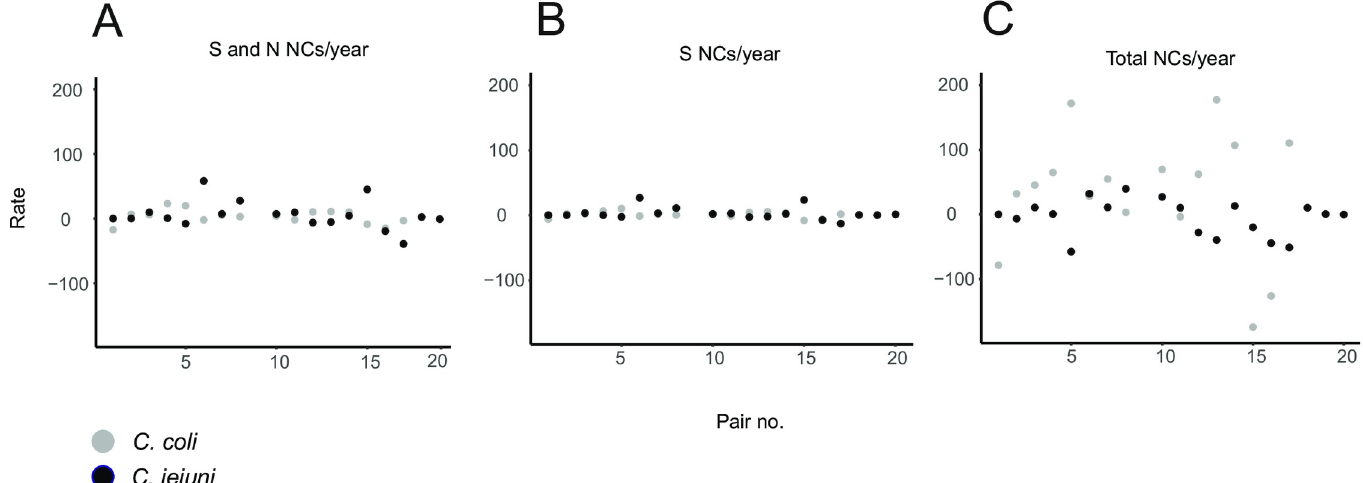
Fig 3. Scatter plots of individual pair NC rates for C . coli and C . jejuni . Three different NC rates were determined per pair for C . coli (grey circles) (18 pairs) and C . jejuni (black circles) (20 pairs): (A) all S (synonymous) and N (nonsynonymous) NCs, excluding those in recombined regions; (B) S NCs only, excluding those in recombined regions (molecular clock); (C) all NCs including those resulting from recombination (total NC rate). Variation was gratest among total NC rates. This demonstrates the impact of recombination, introducing the majority of NC’s into Campylobacter genomes. All remaining information on isolate pairs can be found in S2 Table.